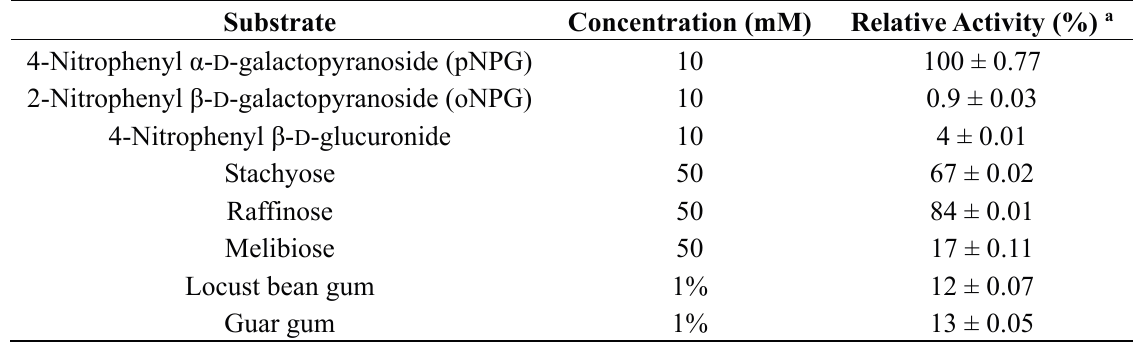
Table 3. Hydrolysis of different substrates by Tricholoma matsutake α -galactosidase.